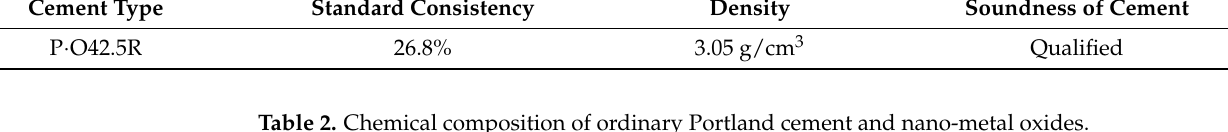
Table 2. Chemical composition of ordinary Portland cement and nano-metal